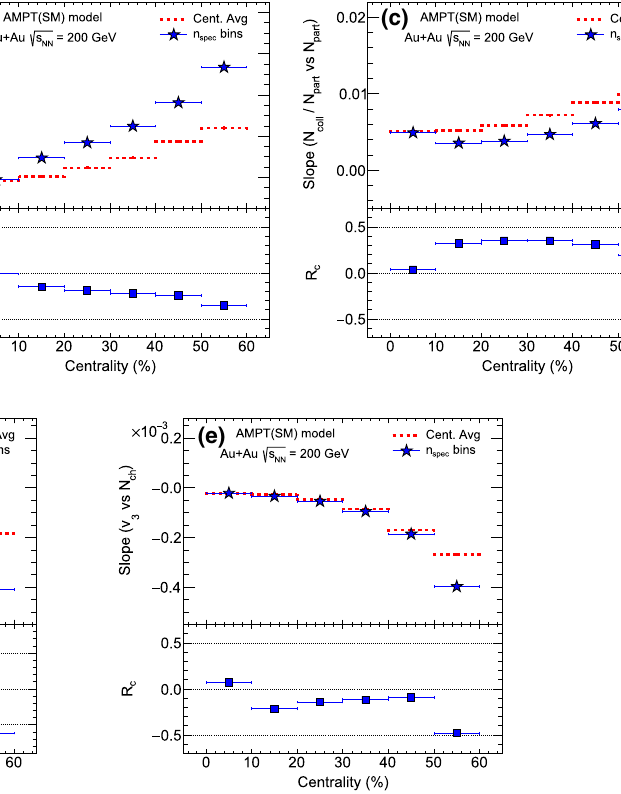
N coll / N part vs. N part . Bottom row: (left) slopes for v 2 vs. N ch ; (right) slopes for v 3 vs. N ch . The bottom panel in all figures shows the relative ratio between slopes; R c as a function of